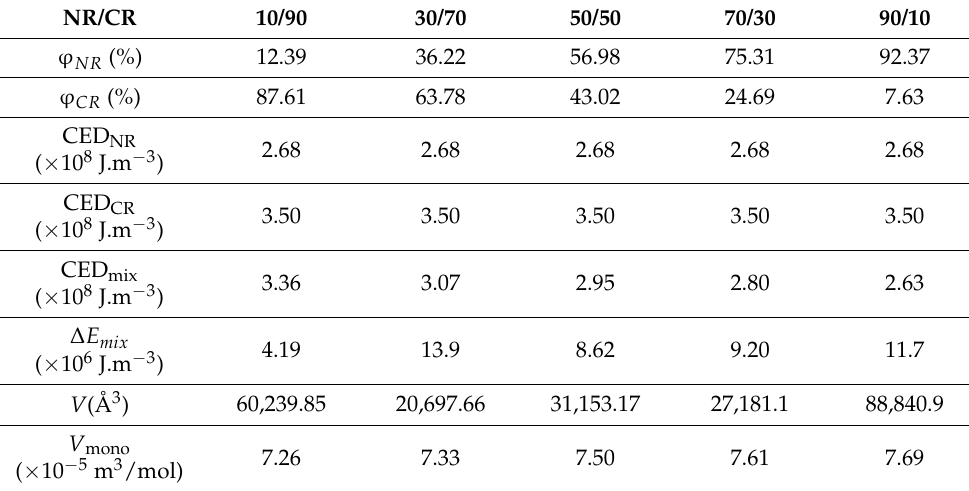
Table 4. Parameters after geometric optimization of the NR/CR blending